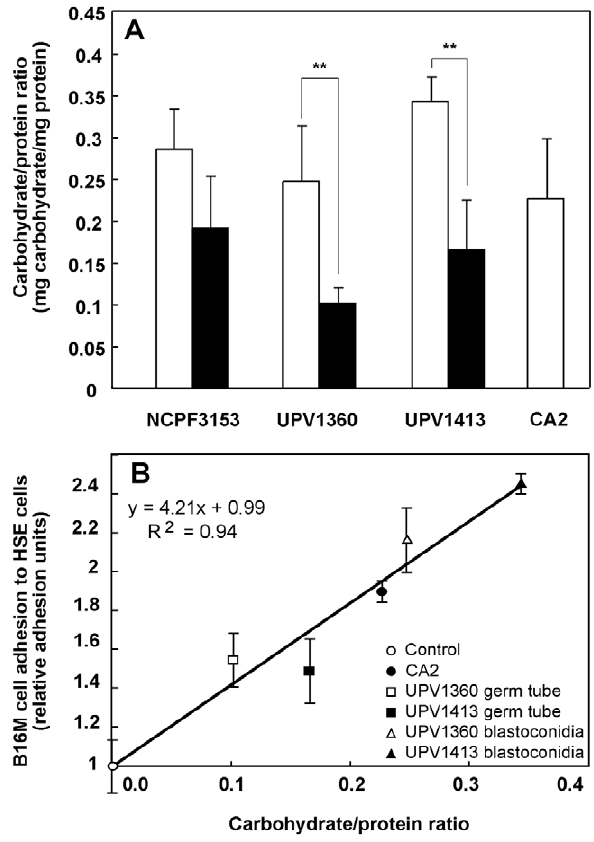
Figure 2. Study of the carbohydrate/protein composition in different strains and morphologies. (A) Carbohydrate/protein ratio in the crude extracts of the different strains of Candida albicans : Blastoconidia ( % ) and germ tubes ( & ). The results shown correspond to the mean 6 SD of three independent experiments. Statistically significant differences between different morphologies are indicated by two asterisks (**) (p , 0.05). (B). Regression line for the B16 melanoma (B16M) cell adhesion to hepatic sinusoidal endothelial (HSE) cells induced by the strains and morphologies of C. albicans that lead a significant effect versus their carbohydrate/protein